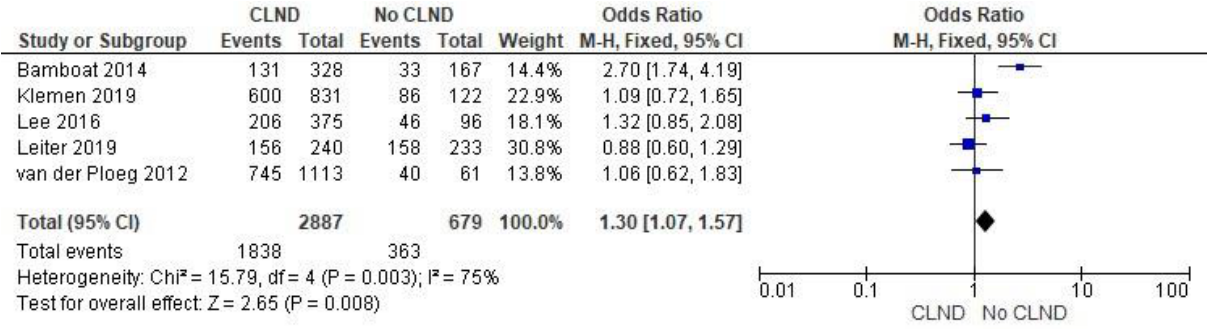
Figure 4. Five-years melanoma survival [3,28 – 30,32].